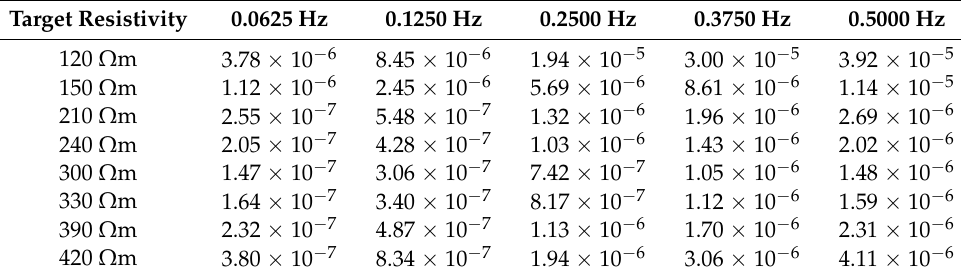
Figure 5. Two-dimensional (2-D) Gaussian process (GP) model with 121 different electromagnetic (EM) profiles for multiple transmission frequencies; ( a ) 0.0625 Hz, ( b ) 0.125 Hz, ( c ) 0.25 Hz, ( d ) 0.375 Hz, and ( e ) 0.5 Hz. Table 2. Mean squared deviation (MSD)